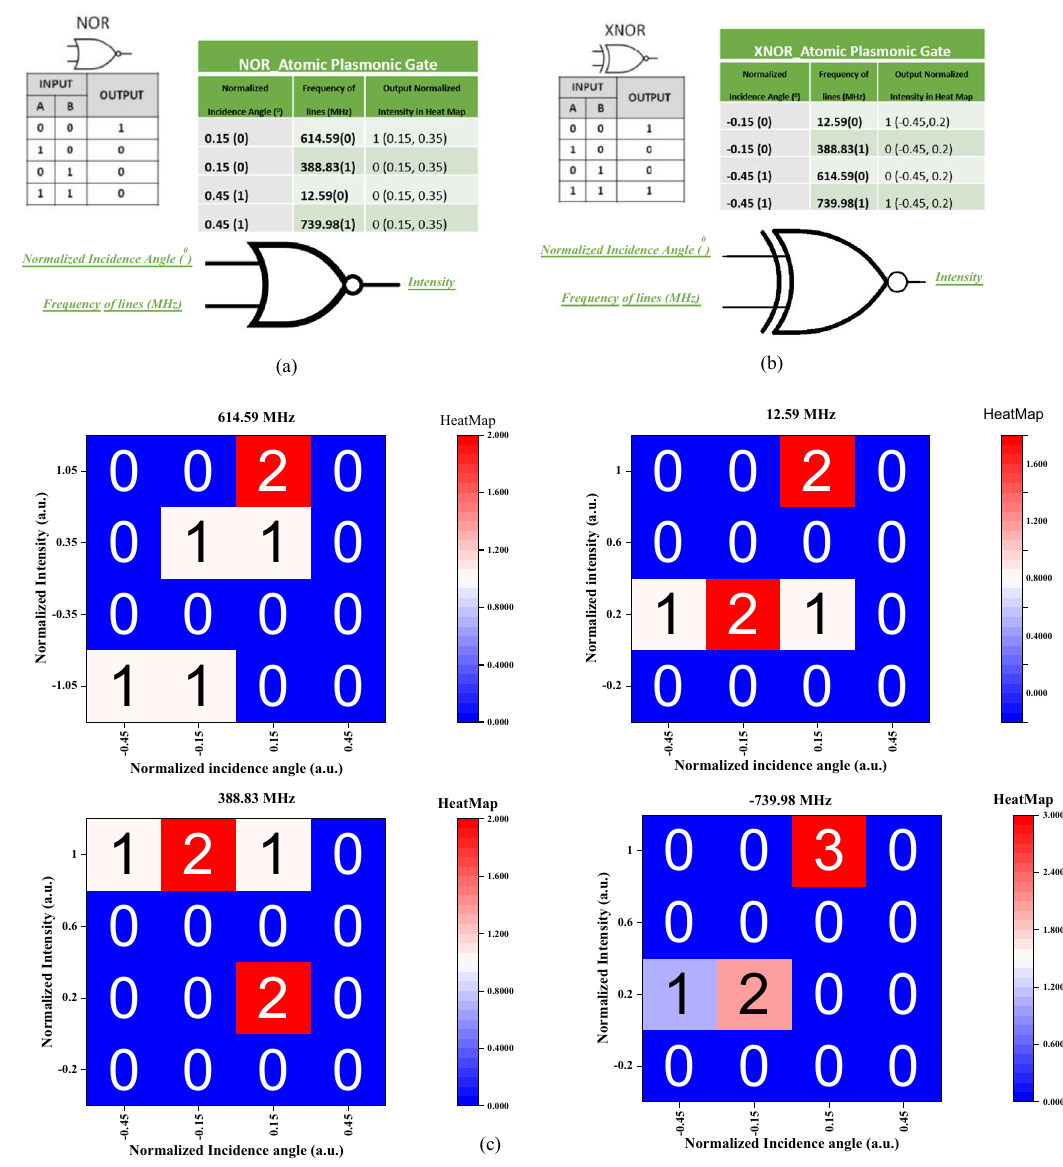
Figure 4. operation of proposed ( a ) NOR and ( b ) XNOR logic gates and ( c ) Heat Maps of logic state based on transmitted intensity at four selected detuning channels of system’s